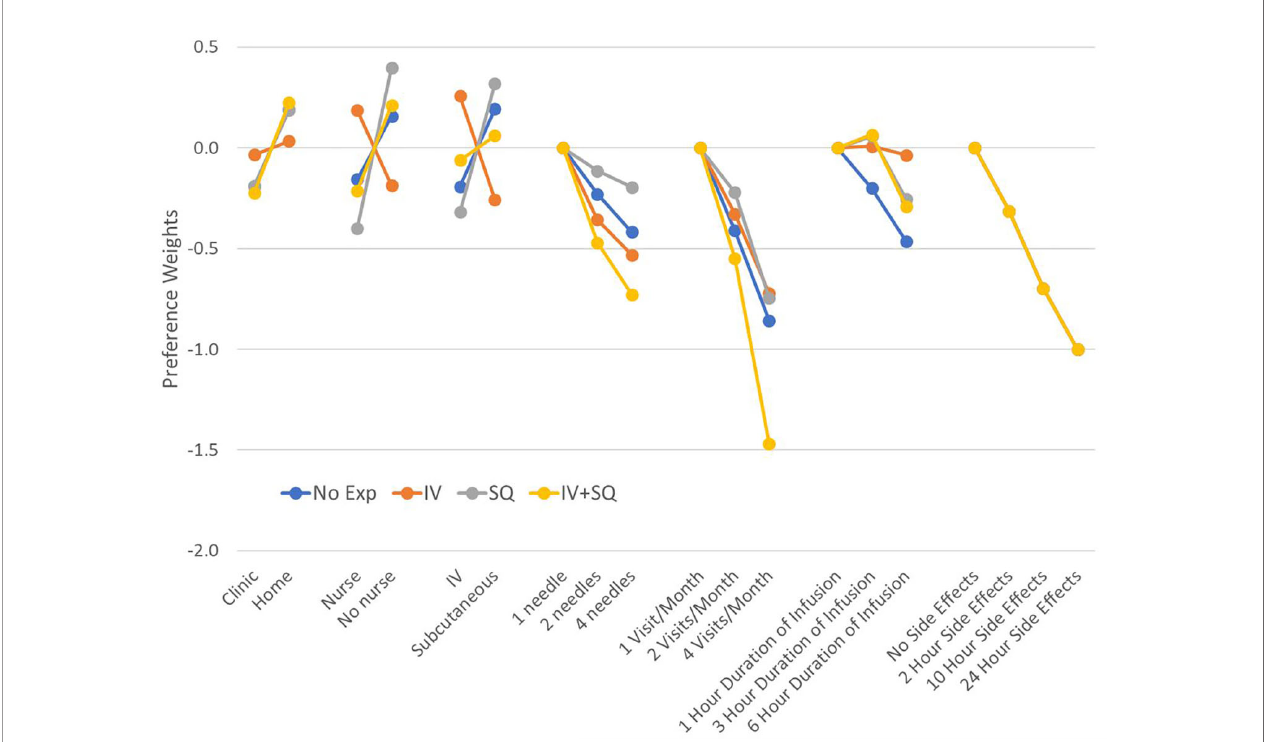
FIGURE 5 | Preference weights by treatment experience. Log-odds preference weights for respondents who reported only using IV therapies (IV), those who reported only experience with (subcutaneous injections), and those who reported experience with both administration options. Results were normalized by overlapping the preference weights for duration of side effects to allow direct comparison between plots. Con fi dence intervals are not shown to facilitate reading the fi gure. Estimates and 95% con fi dence intervals for each subgroup are included in Appendix B No exp, No experience with any therapy; IV, Only experience with IVIG; SQ, Only experience with subcutaneous injections; IV+SQ, Experience with both IVIG and subcutaneous